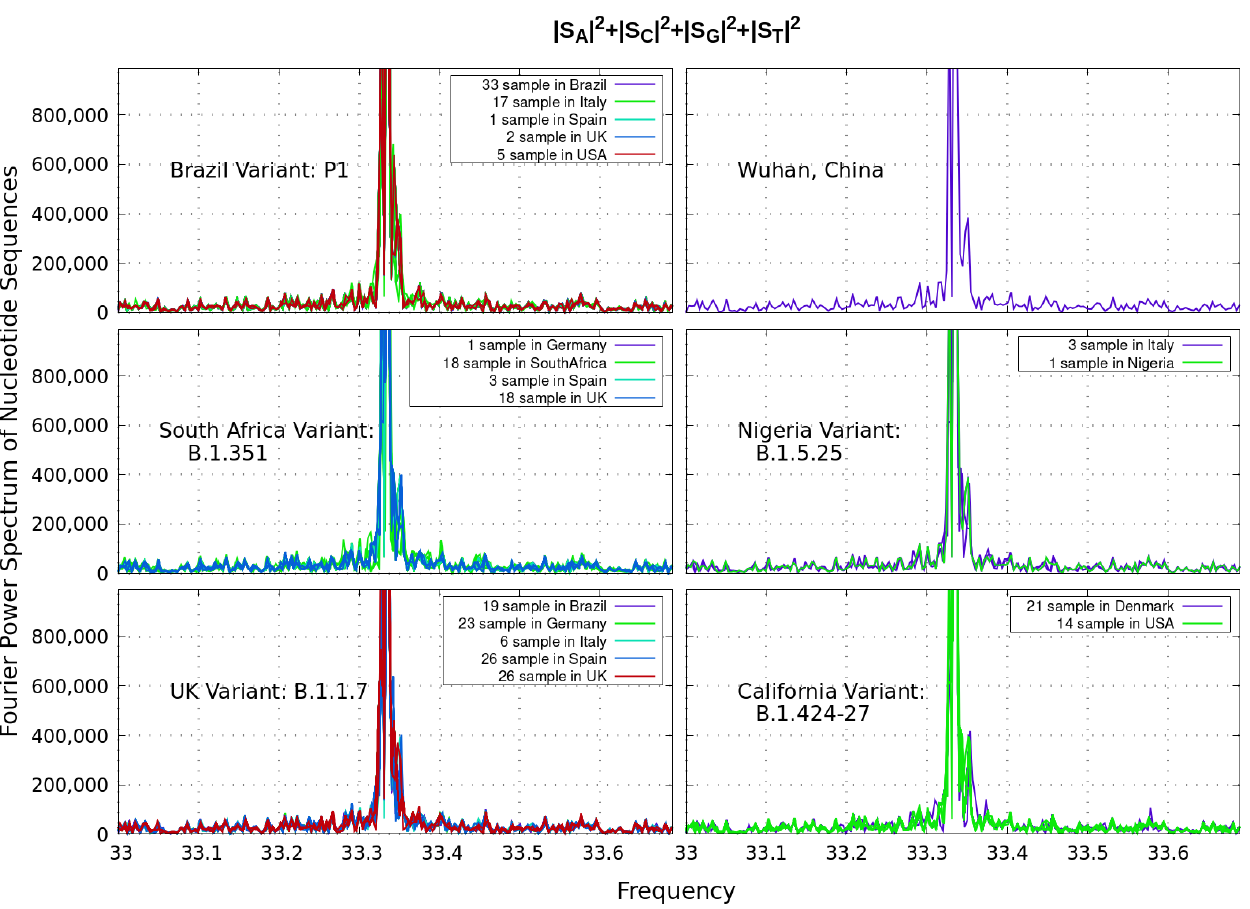
Figure 2. Discrete Fourier Transform identifying base periodicity property of the coronavirus sequence. The plots reveal a distinct peak above noise level at around ‘frequency’ 33.3333 for all variants considered. The differences shown in brackets for a given country correspond to data from a given